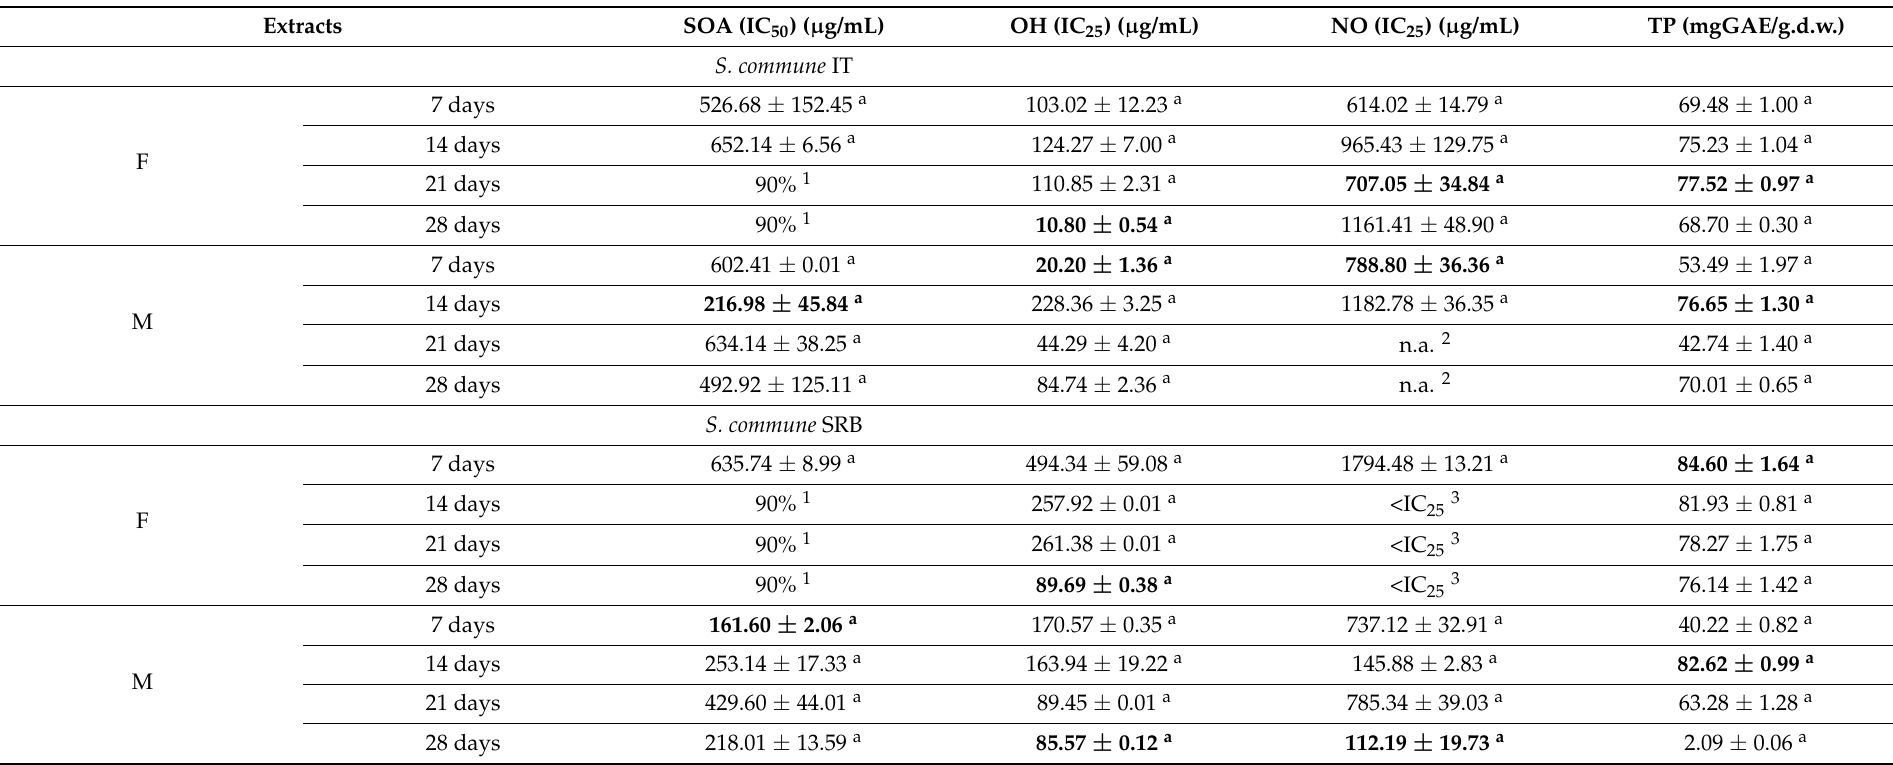
Table 2. Antiradical activity and total phenol content (TP) of submerged EtOH extracts of S. commune strains from Italy (IT) and Serbia (SRB). F—filtrate; M—mycelium; 7–28 days—Incubation time; GAE—gallic acid